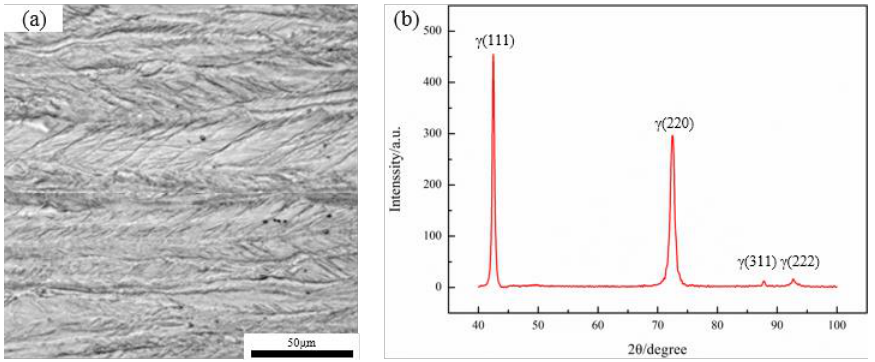
Figure 1. ( a ) Microstructure of Cold Rolled Experimental Steel; ( b ) XRD of Cold Rolled Experimental Steel. Figure 2 is the XRD diffraction pattern of cold rolled experimental steel annealed at 900~1100 °C for 15 min and TEM morphology and diffraction spots. The test results show that the experimental steel consists of austenite and trace amount of κ -carbide.